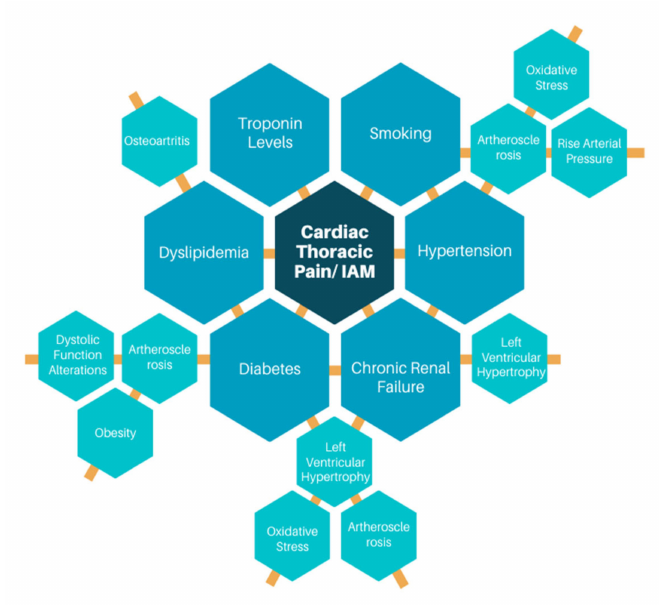
Figure 2. Relationship between secondary risk factors